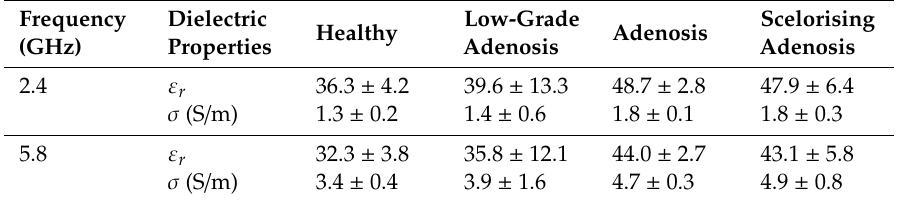
Table 4. Mean of all in vivo dielectric property measurement comparisons collected from healthy and benign rat mammary tissues along with uncertainty values at Industrial, Scientific, Medical (ISM) bands.